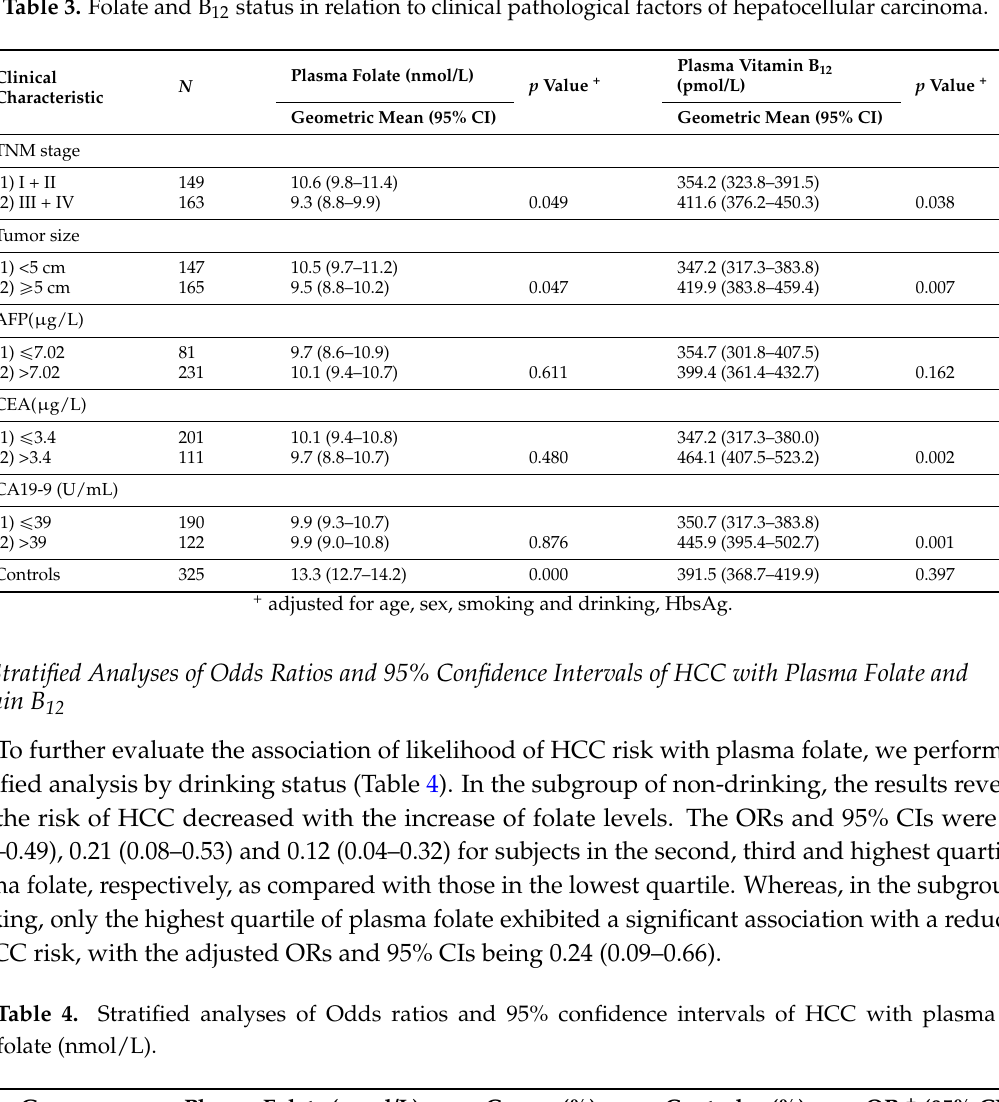
Table 3. Folate and B 12 status in relation to clinical pathological factors of hepatocellular carcinoma.